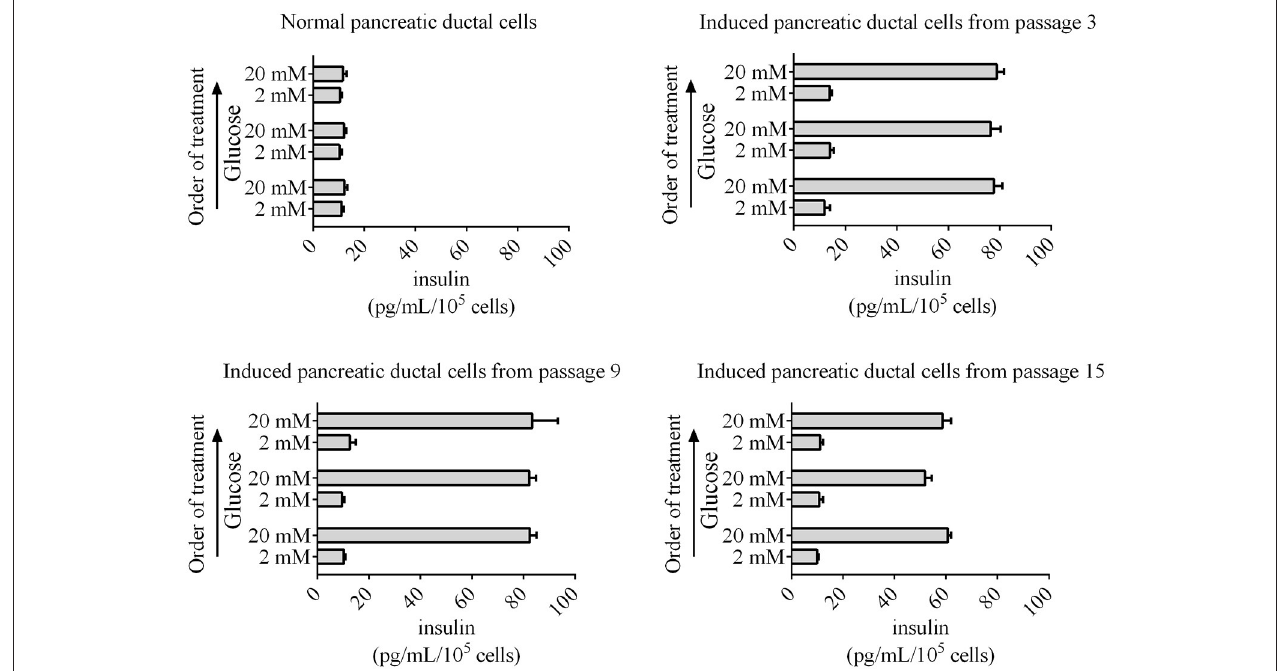
FIGURE 6 | Glucose-stimulated insulin secretion by induced pancreatic ductal cells derived from different passages. An ELISA was used to measure secreted insulin from cells stimulated sequentially with 2, 20, 2, 20, 2, and 20mM glucose with 30min of incubation for each concentration. Insulin was secreted from induced pancreatic ductal cells but not normal pancreatic ductal cells ( n =